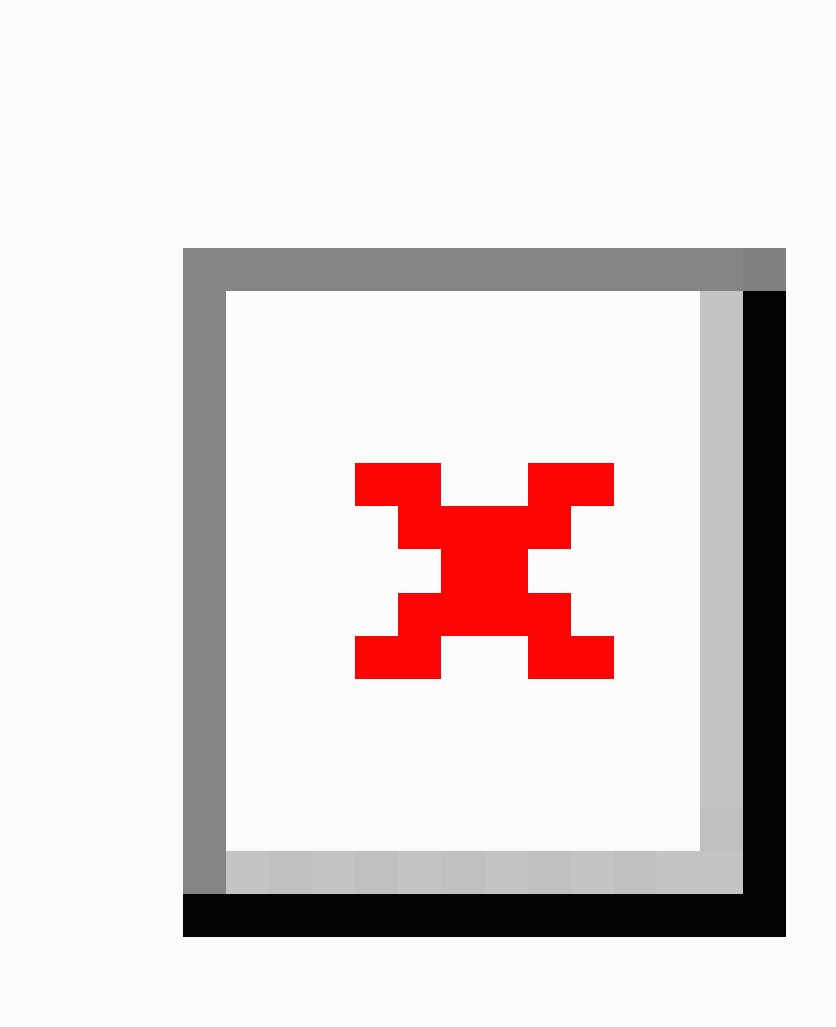
Figure 2. The construction dates of internet hospitals in China. (A) The construction dates of internet hospitals in China by month. (B) The construction dates of internet hospital in China by year. The following important policies were issued during the COVID-19 epidemic in China: (1) Notice on internet diagnosis and treatment consultation services for COVID-19 prevention and control (February 6, 2020), (2) Notice on strengthening internet diagnosis and treatment consulting services for COVID-19 prevention and control (February 8, 2020), (3) Notice on the national telemedicine and internet medical center for the national remote consultation of critically ill patients with COVID-19 (February 21, 2020), (4) Notice on further promoting the development and standardized management of internet medical services (April 18, 2020), and (5) Notice on the technical specifications and financial management of the "Internet+ medical service" project of public medical institutions (May 8,